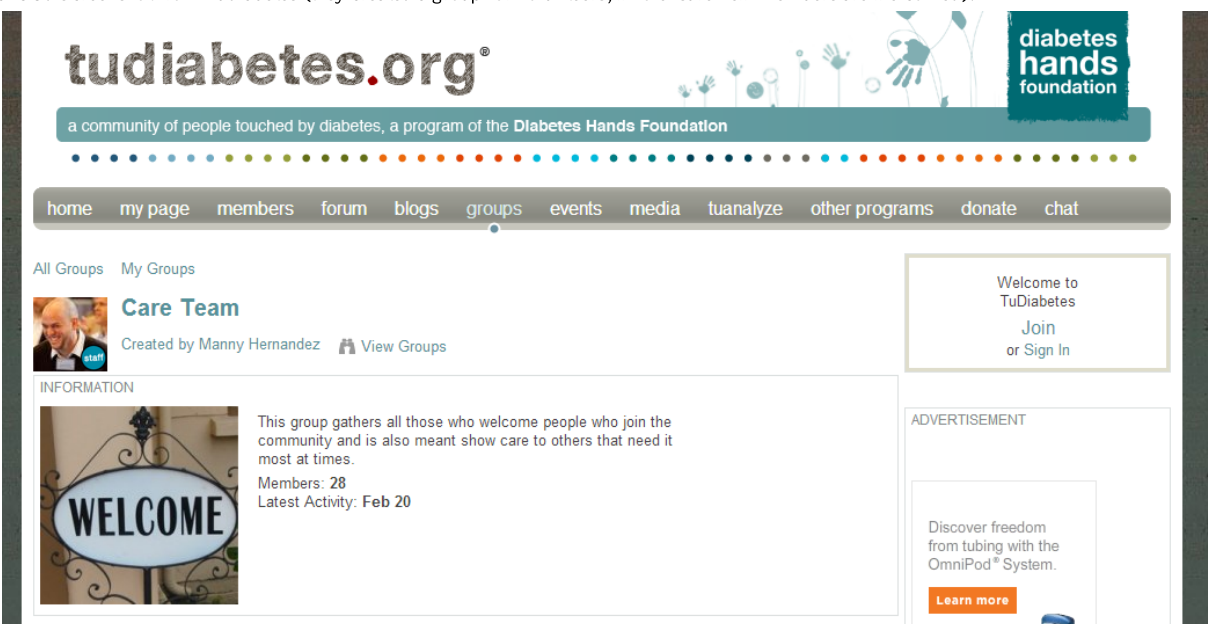
Figure 3. Screenshot from Tudiabetes (they created a group for volunteers, who ensure new members are